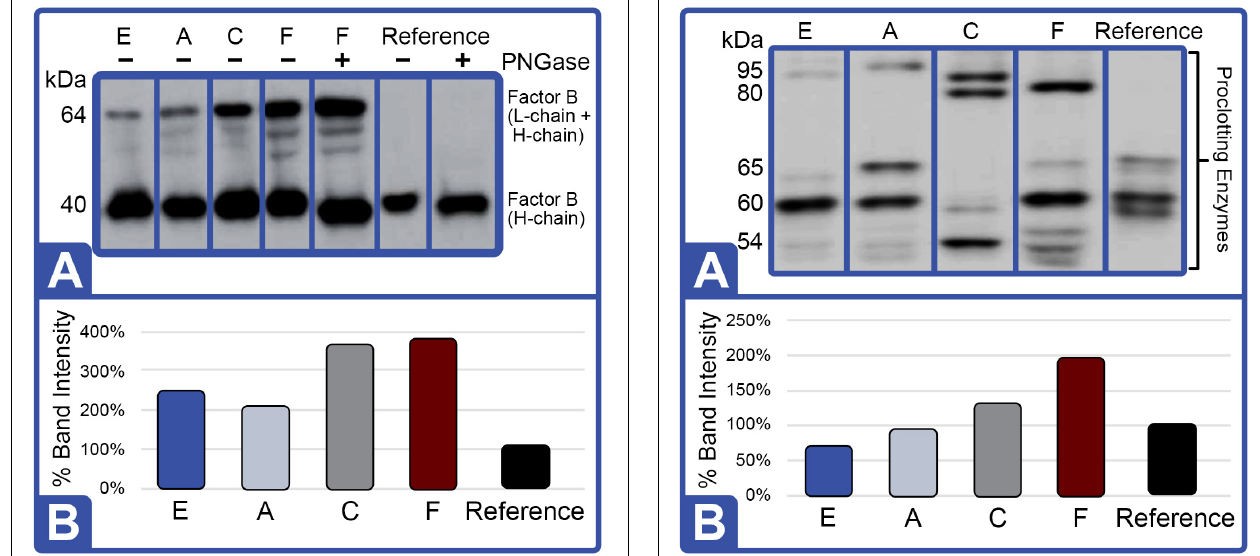
FIGURE 8 | Effect of Diet on Proclotting Enzyme Protein Expression (Feed Study 3). (A) Western blot of crude lysates (5 µ g) of LAL from each diet analyzed vs. reference LAL. Extracts from Diet E (Lane 1), Diet A (Lane 2), Diet C (Lane 3), Diet F (Lane 4), and reference LAL (Lane 5) with See Blue+2 molecular weight marker. Each sample was resolved across 8.0% Tris-Glycine gel and transferred to PVDF membrane. Proteins analyzed by membrane incubation with anti-proclotting enzyme polyclonal rabbit antibodies (Factor IX). (B) Total proclotting enzyme protein abundance (% band intensity) quantified on an imaging device.